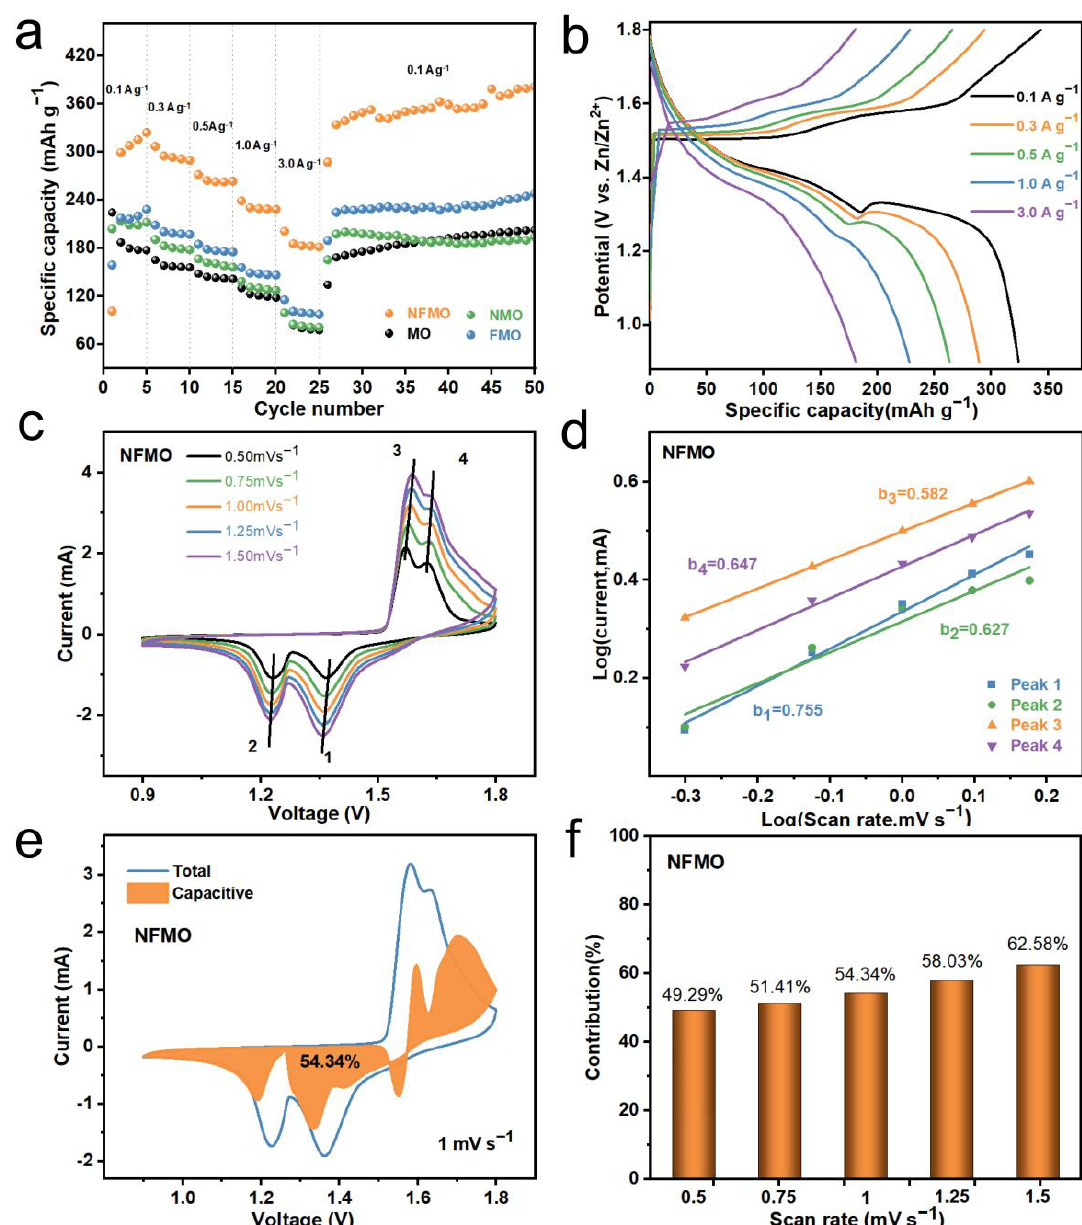
Figure 3. ( a ) Rate performance of the four cathodes. ( b ) Charge/discharge profiles of NFMO at different current densities from 0.1 to 3 A g −1 . ( c ) CV curves of the NFMO electrode at various scan rates. ( d ) The corresponding plots of log (current) vs. log (scan rate) of MO at each redox peak, and corresponding b values. ( e ) Capacitive and diffusion-controlled percentage of NFMO at a scan rate of 1 mV s −1 . ( f ) Contribution ratios of the capacitive capacities and diffusion-controlled capacities in the NFMO electrode.